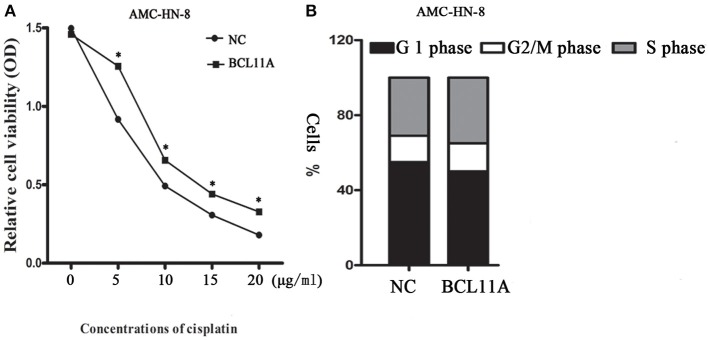
(A) Influence of different concentrations of cisplatin on the cytotoxicity of negative controls (NC) AMC-HN-8 and overexpression BCL11A AMC-HN-8 cell strains. (B) Cell cycle investigation, showing that overexpression did not affect cell cycle kinetics in the two cell lines. The data are the mean ± s.d. (n = 3).*P < 0.05.